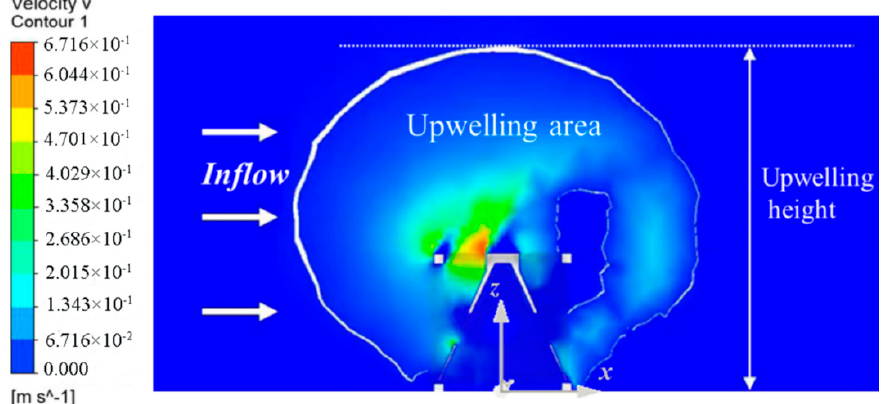
Figure 4. Velocity profile of the x - z plane ( y = 0).